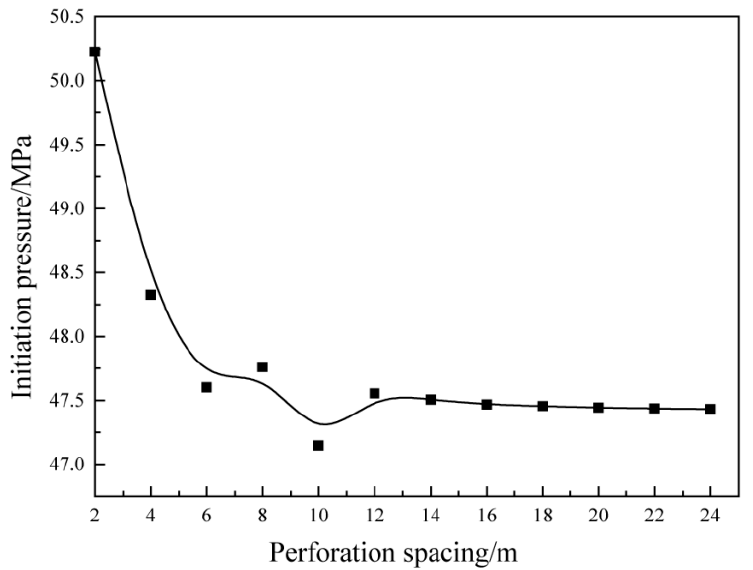
Figure 12. Relation curve between initiation pressure and perforation spacing. With the increase in perforation spacing, the initiation pressure decreases and it will not change when the spacing reaches a certain value.